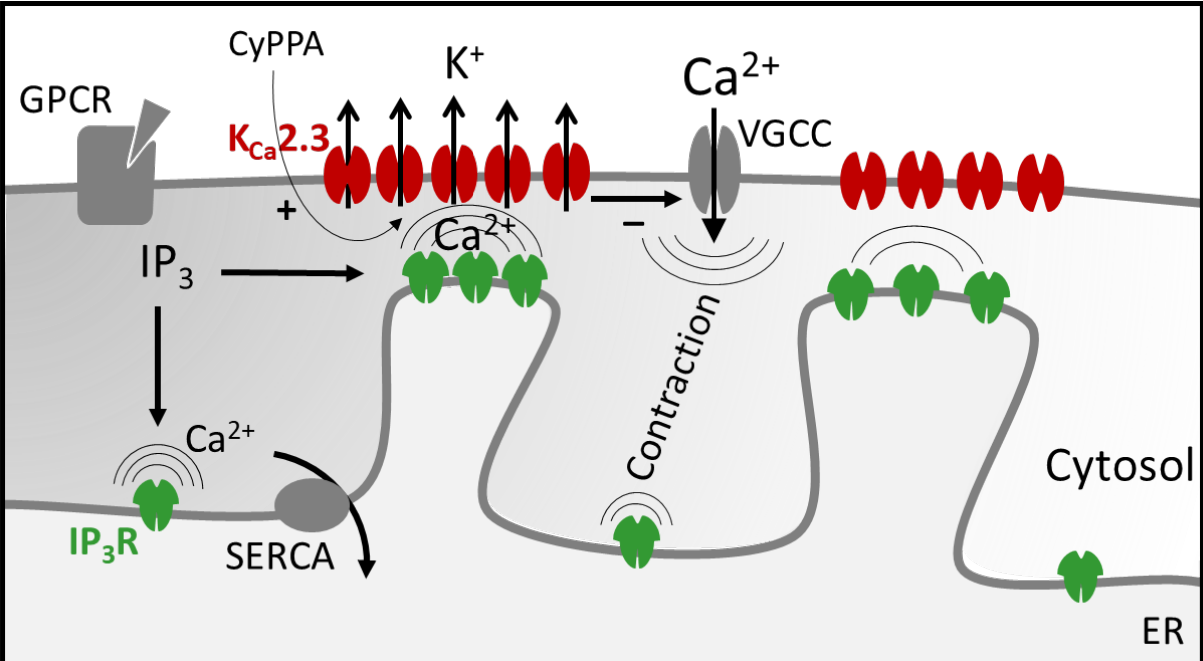
Figure 5. Schematic of proposed internal Ca 2+ store feedback regulation of uterine contractions. Action potentials elicit phasic myometrial contractions by opening smooth muscle VGCCs. GPCR binding by oxytocin normally augments contractions via IP 3 -dependent release of internal (ER) Ca 2+ stores. Concurrently, local Ca 2+ release sites positioned near membrane K Ca 2.3 channels solicit negative feedback control of VGCC influx, and limit overall contraction. Introduction of CyPPA increases the Ca 2+ sensitivity of K Ca 2.3 channels, thereby, potentiating K Ca 2.3 feedback regulation. Heightened sensitization of internal store feedback may effectively block productive contractions in the presence of oxytocin.